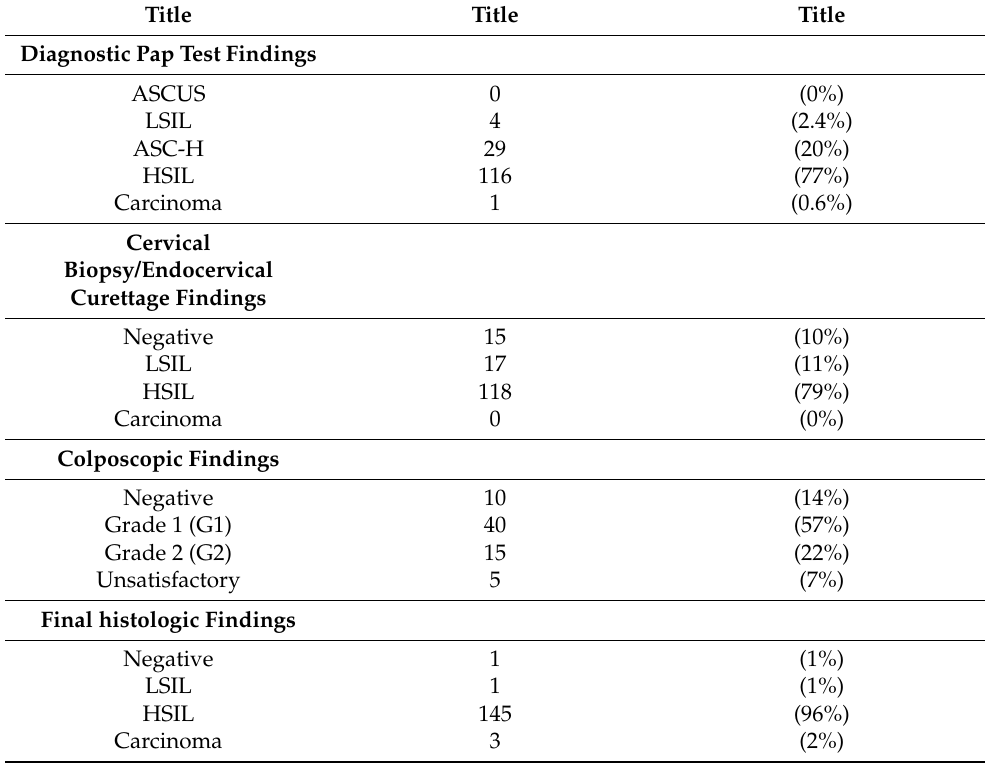
Table 2. Clinicopathological characteristics of